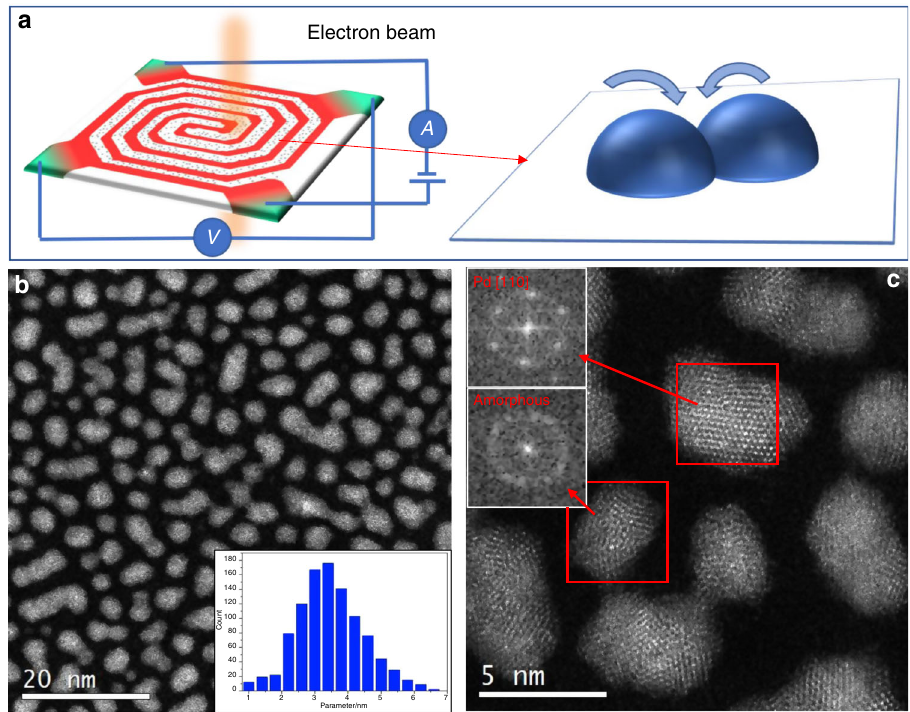
Fig. 1 Experiment setup and TEM observation on the as-prepared sample. a Schematic diagrams showing the experimental setup for in situ TEM observations on particles sintering. Resistance wires on micro-chip enable precise control of temperature by electrical current. b Low-magni fi cation HAADF-STEM image of the as-deposited PdSi nanoparticles on the observation window. The inset image shows the statistical size distribution of PdSi nanoparticles. c HAADF-TEM image of as-deposited PdSi nanoparticles, showing the co-existence of crystalline and amorphous